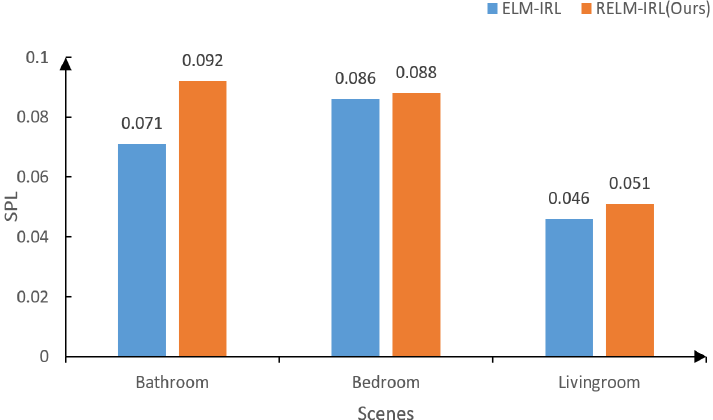
Figure 11. Experimental results of regularized ELM. The orange and blue represent the SPL of ELM-IRL with and without regularization,